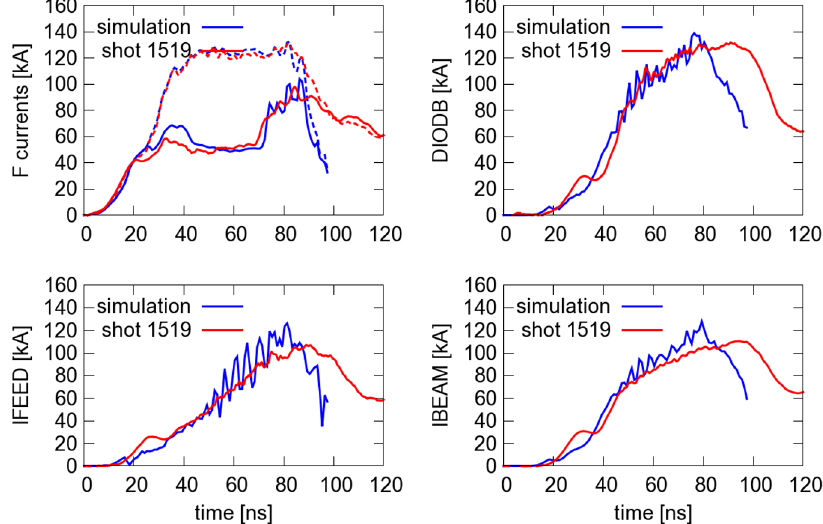
FIG. 9. Currents in the MITL, dustbin, and diode from a simulation of shot 1519 compared to data. The diode has a 7-mm diameter needle and a 7-mm AK gap. The falling diode impedance is modeled using massive fluid electrons at the anode which drift away from the surface and effectively reduce the AK gap.